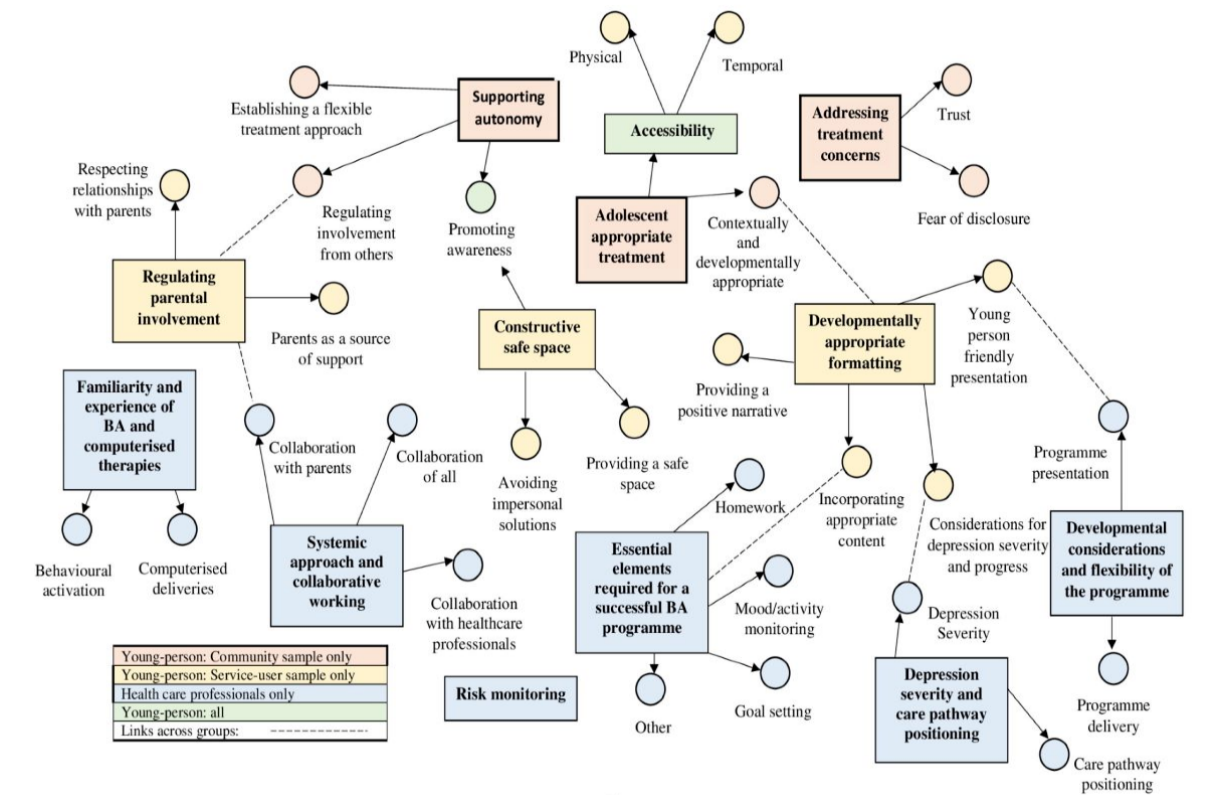
Figure 1. Thematic map of young person participants and health care professionals’perspectives. BA: behavioral activation.